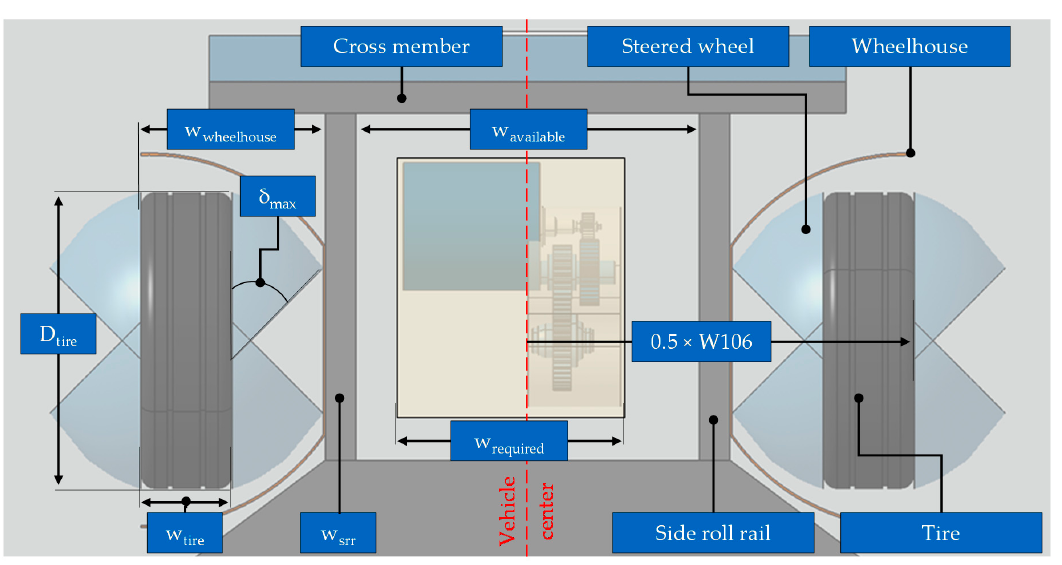
Figure 3. Overview of the relevant measures at the front end of the vehicle, based on Reference